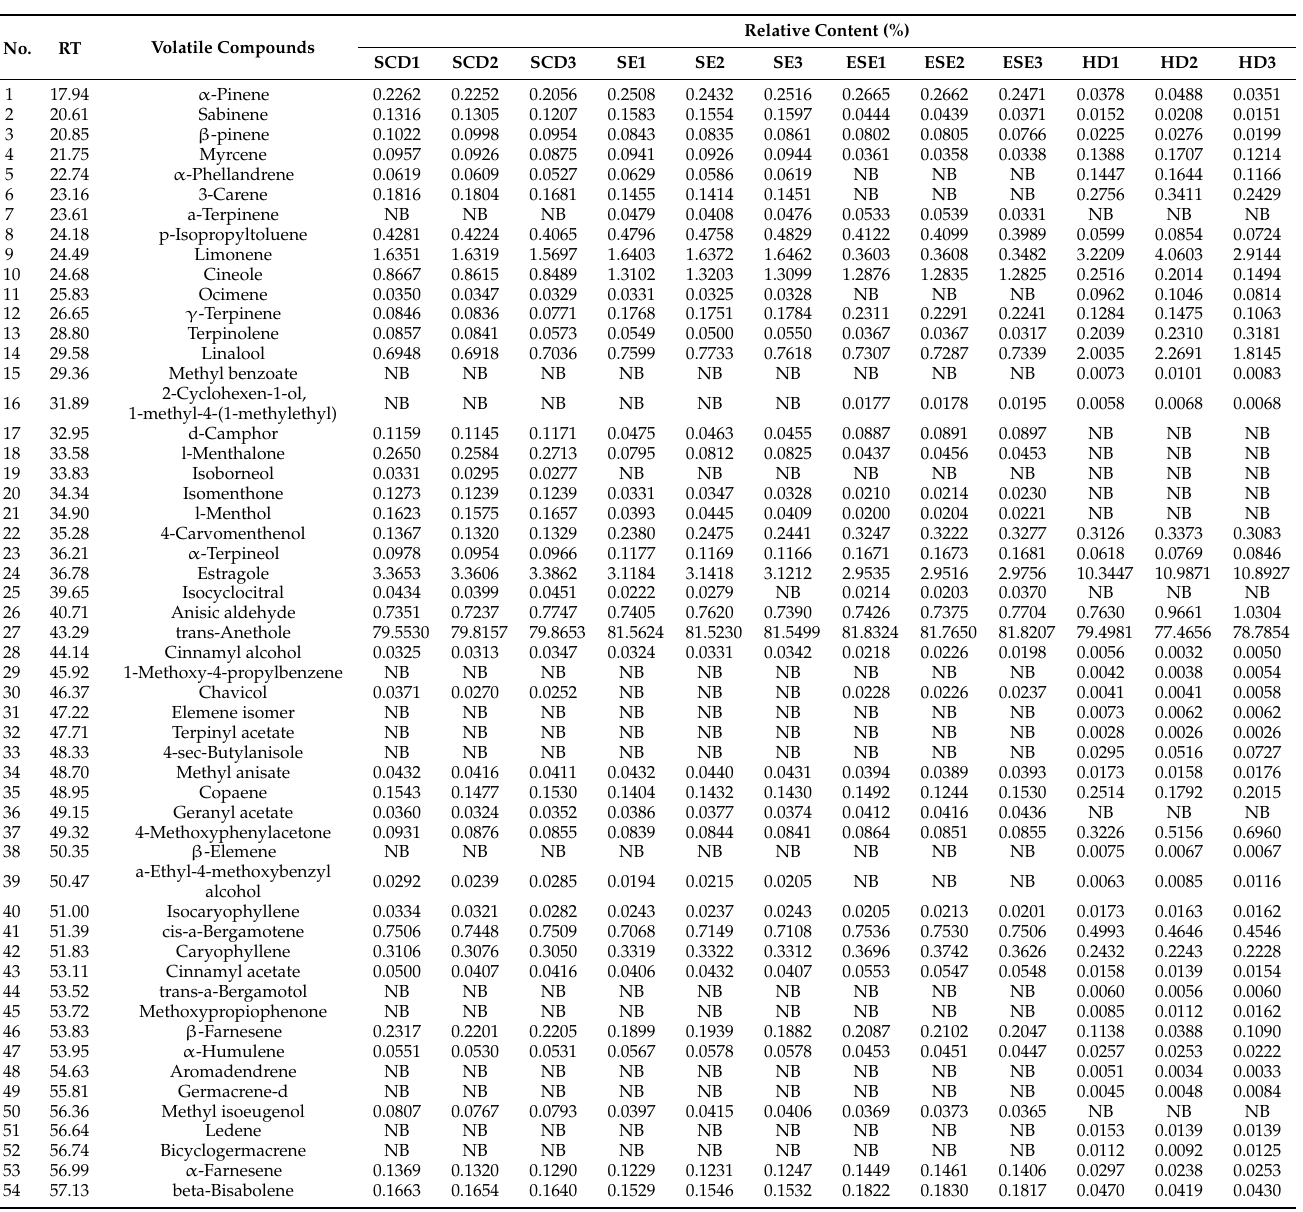
Table 2. GC-MS Analysis component diagram of SAEO extracted by different methods 1